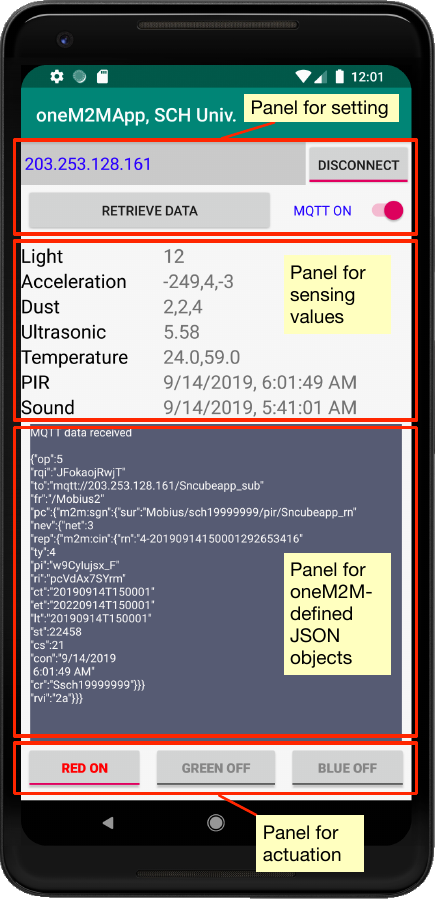
Figure 7. The captured image of the oneM2M Android